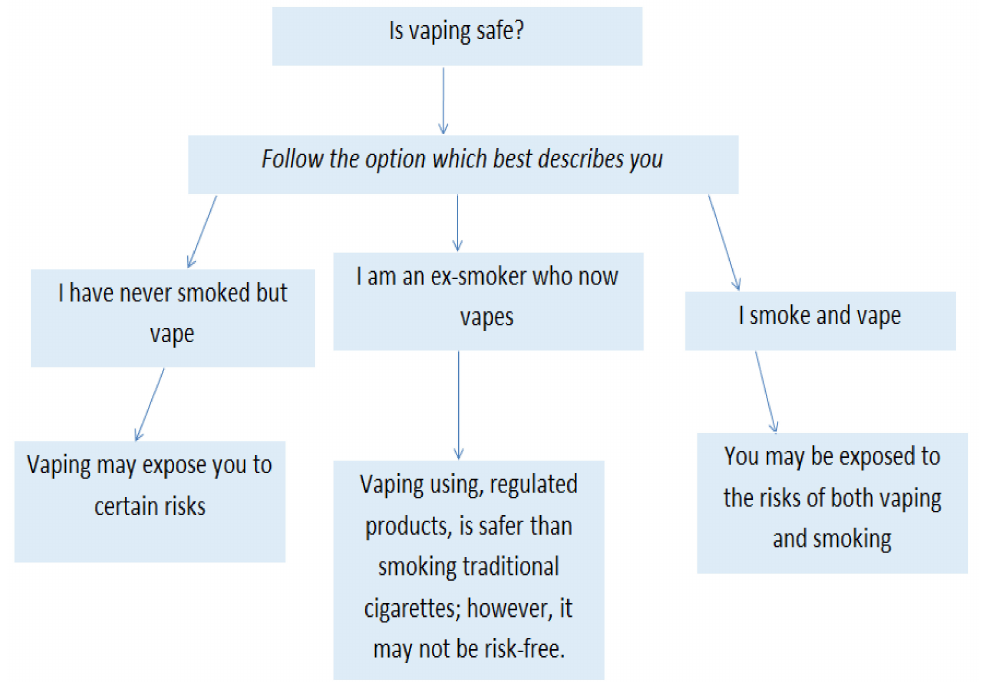
Figure 3. Flowchart based on current by Centers for Disease Control, the NHS, and Cancer Research UK